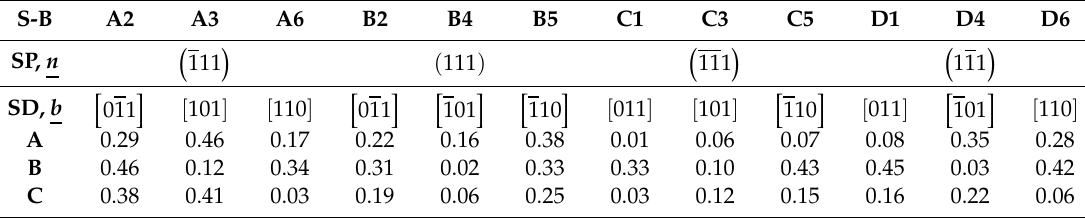
Table 2. Schmid–Boas notation (S–B) for the four slip planes (SP) and slip direction (SD), as well as the corresponding Schmid factors for the orientations A, B, and C (see Table 1).